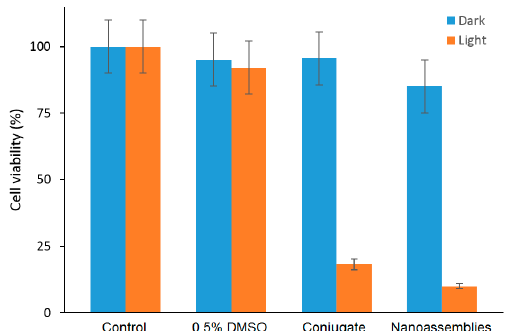
Figure 28. Dark and photoinduced mortality of A375 cells treated with meta -(3-hydroxyphenyl)- porphyrin (mTHPP)- β -CD conjugate and mTHPP- β -CD/nitric oxide (NO) photodonor assemblies (ca. 8 mm) in culture medium containing 0.5% DMSO compared to dark and photoinduced mortality in culture medium in the absence and the presence of 0.5% DMSO. Adapted from Fraix; Goncalves; Cardile; Graziano; Theodossiou; Yannakopoulou; Sortino [145].